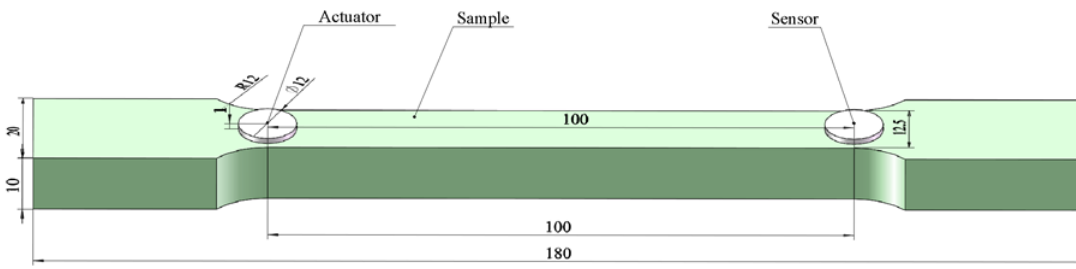
Figure 3. Dimensions of the sample and the PZTs (unit: mm).